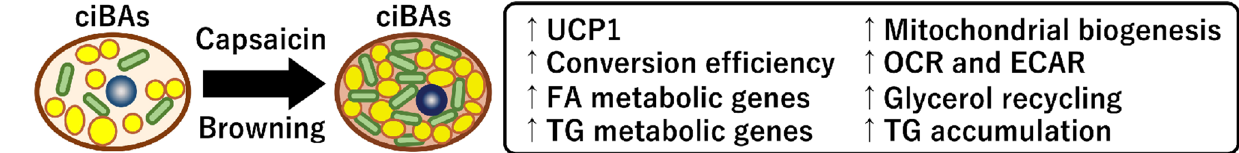
Figure 7. Schematic presentation of the browning effects promoted by Capsaicin in ciBAs. The treatment with Capsaicin induces the expression of the brown adipocyte-specific gene, UCP1 , and a series of metabolic genes involved in fatty acid (FA) metabolism, triglyceride (TG) metabolism, glycolysis pathway, and adaptive thermogenesis. Moreover, Capsaicin increases the efficiency of the direct conversion, mitochondrial biogenesis, OCR and ECAR, glycerol recycling, and TG accumulation, which are closely associated with functions in brown (HDFs), AdMSCs, and bone marrow-derived mesenchymal stem cells (BmMSCs) were examined (Fig. 6F). ciBAs converted from HDF35 and HDF54 in the presence of Capsaicin exhibited higher expression levels of